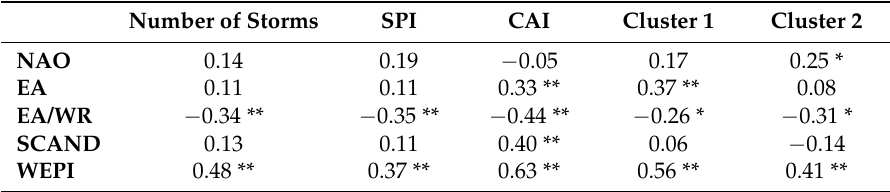
Table 5. Spearman´s rank correlation coefficients between winter (DJF) teleconnection patterns versus storm parameters and atmospheric indices (*/** statistically significant at the 95%/99% confidence